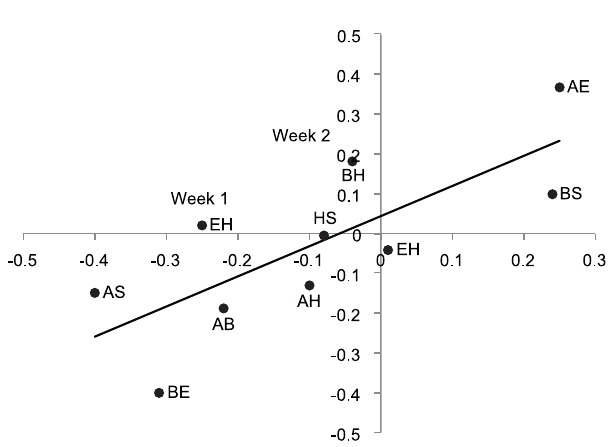
Figure 4. Behavioural syndrome structure is consistent over time in rock pool prawns. Each point represents the correlation coefficient between two traits for week one and week two. Trait combinations are indicated using the following notation: A=activity, B=boldness, E=exploration, H=habitat preference, S=shoaling ten- dency.